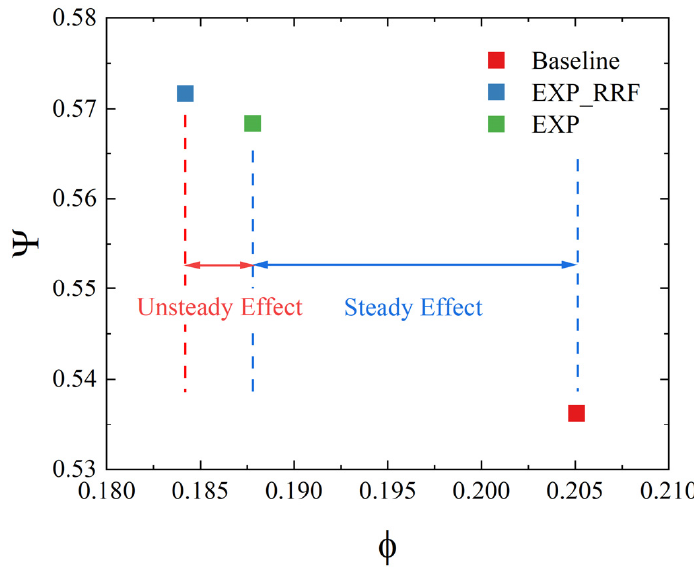
Figure 14. The summary of stall points of TA36.